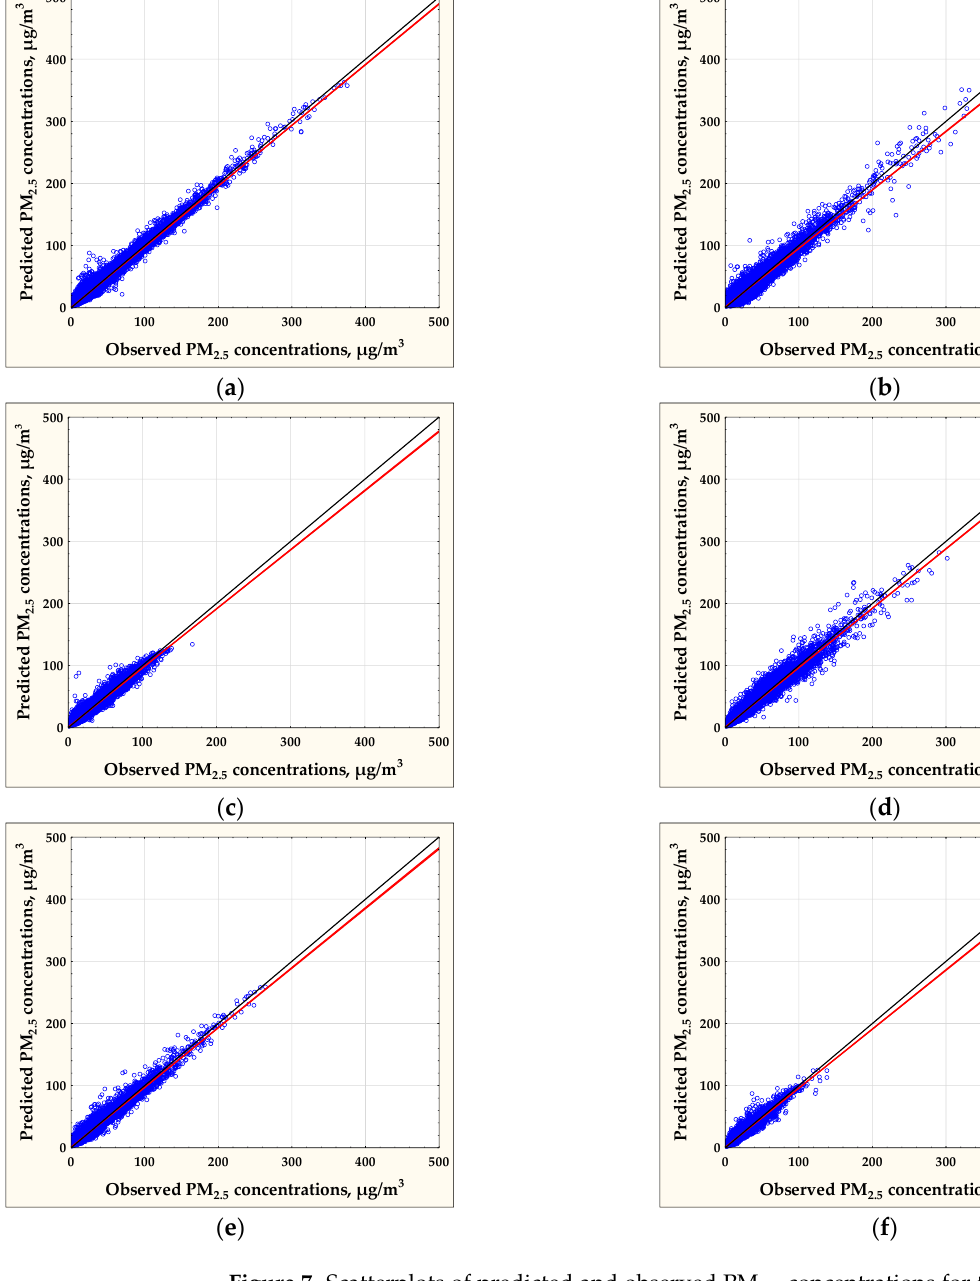
Figure 7. Scatterplots of predicted and observed PM 2.5 concentrations for the models MLP 7-10-1: ( a ) Jelenia Gora air monitoring station model (best linear fit y = 0.977x + 0.451, R 2 = 0.976); ( b ) Lublin air monitoring station (best linear fit y = 0.942x + 1.303, R 2 = 0.944); ( c ) Plock air monitoring station (best linear fit y = 0.952x + 0.909, R 2 = 0.951); ( d ) Radom air monitoring station (best linear fit y = 0.956x + 1,057, R 2 = 0.957); ( e ) Kedzierzyn-Kozle air monitoring station (best linear fit y = 0.962x + 0.929, R 2 = 0.960); ( f ) Olsztyn air monitoring station (best linear fit y = 0.951x + 0.785, R 2 = 0.949).